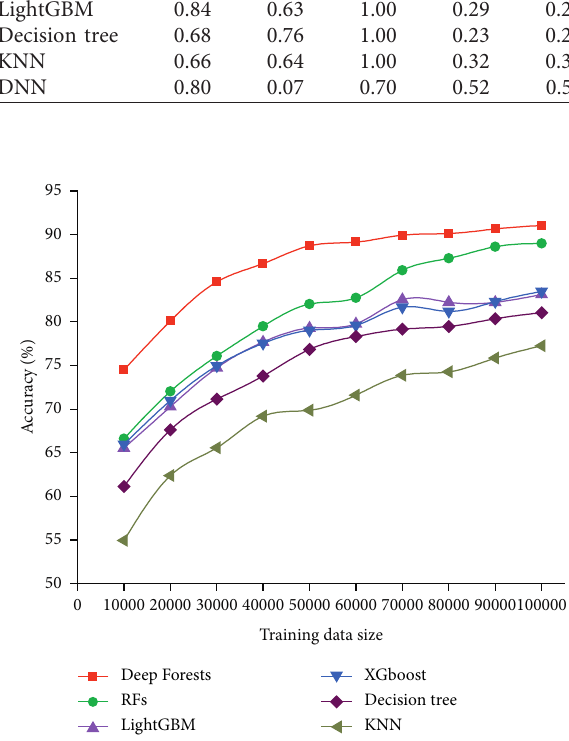
Figure 11: Accuracy rate comparison under different training data